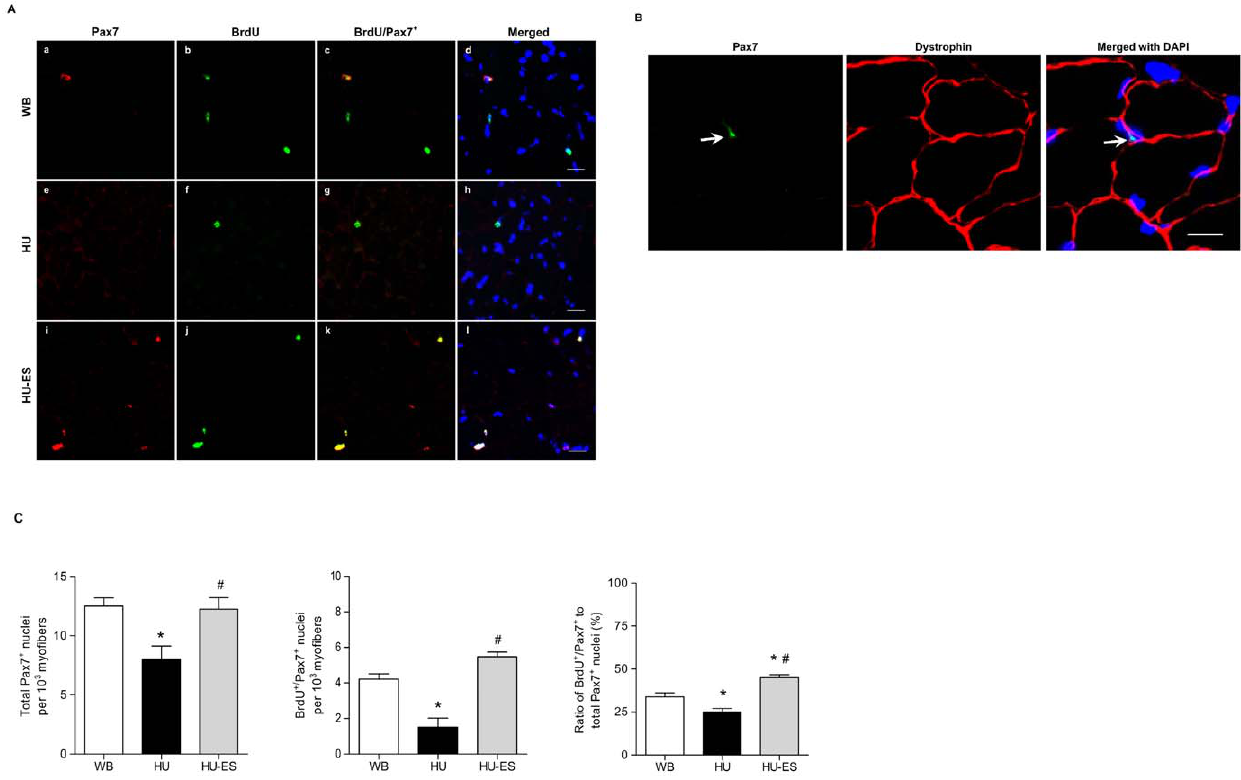
Figure 2. Satellite cell proliferation. (A) Immunohistochemically stained cross-sections of soleus muscle from weight-bearing (WB), hindlimb- unloaded (HU), and electrically stimulated (HU-ES) groups showing expression of Pax7 (red) and BrdU (green) incorporation counterstained with DAPI (blue) for nuclei identification. Yellow staining represents Pax7 and BrdU double-positive nuclei. Scale bar=25 m m. (B) Co-immunostaining of Pax7 and dystrophin on muscle cross-section for satellite cell localization. A Pax7 + nucleus (green, arrow ) located outside the dystrophin + (red) plasma membrane of a myofibre. DAPI (blue) shows the nuclei. Scale bar=20 m m. (C) Total Pax7 immunoreactive nuclei; BrdU + /Pax7 + double-positive nuclei per 10 3 myofibers; and ratio of BrdU + /Pax7 + nuclei within the total Pax7 + population. *p , 0.05, significant difference compared to WB group; # p , 0.05, significant difference compared to HU group. Values are means 6 SEM.